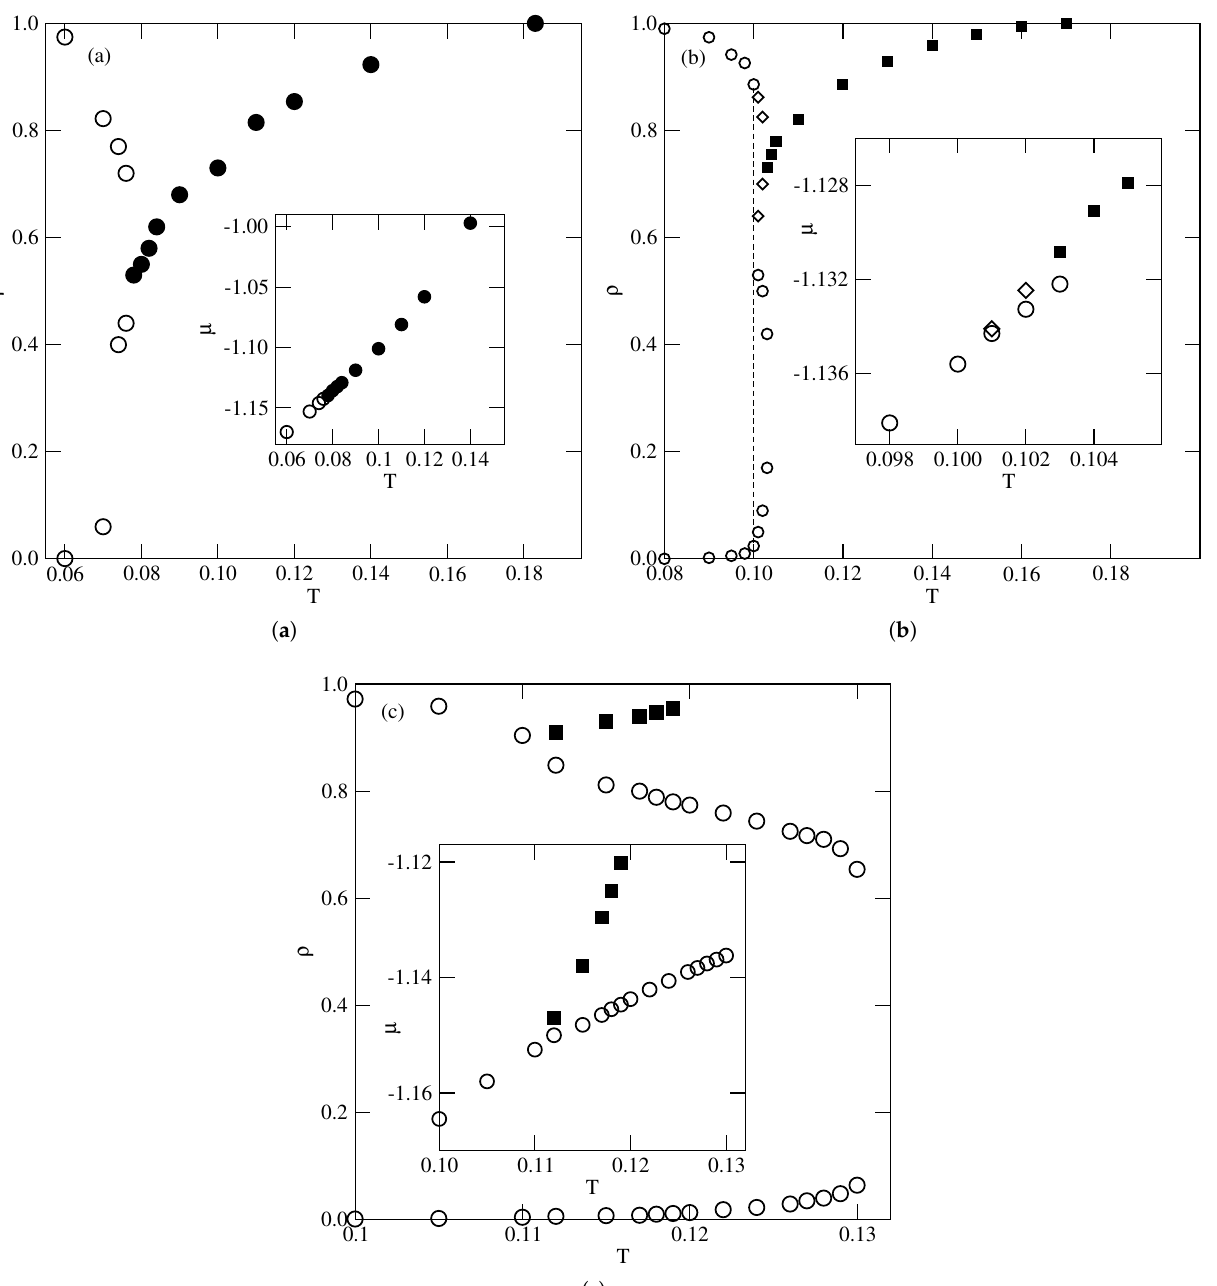
Figure 15. The estimated phase diagrams for the systems with u BB = 0 and different values of u AB , equal to − 0.05 ( a ), − 0.1 ( b ) and − 0.15 ( c ). The main figures and insets show the T − ρ and the T − µ projections, respectively. The vertical line in part b marks the location of the triple point. Open and filled symbols correspond to the first − order and continuous transitions, respectively. In part b, the low and high density transitions are marked by circles and diamonds,